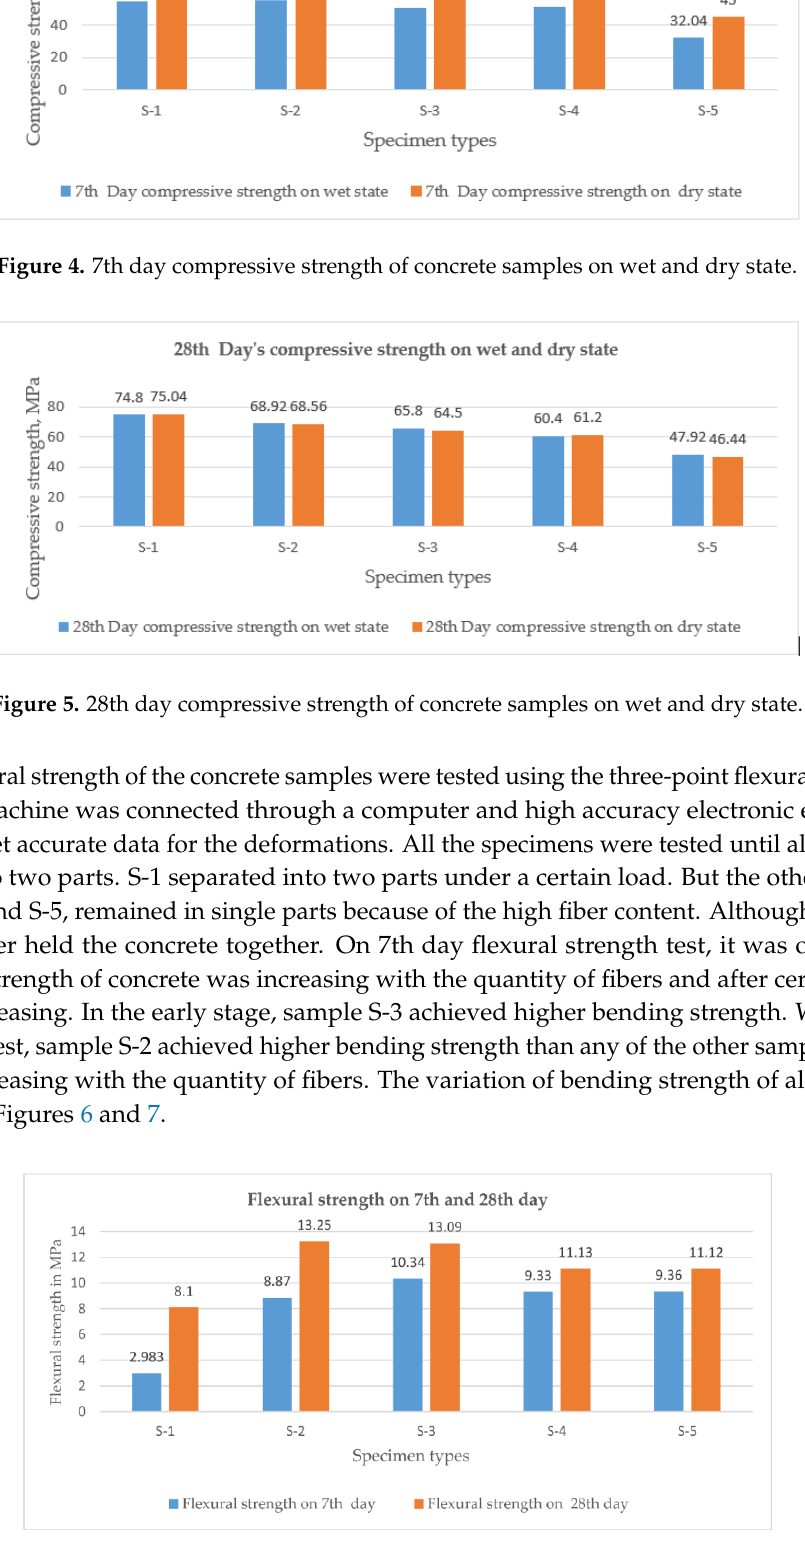
Figure 6. Flexural strength of concrete samples after 7 and 28 days of hardening.